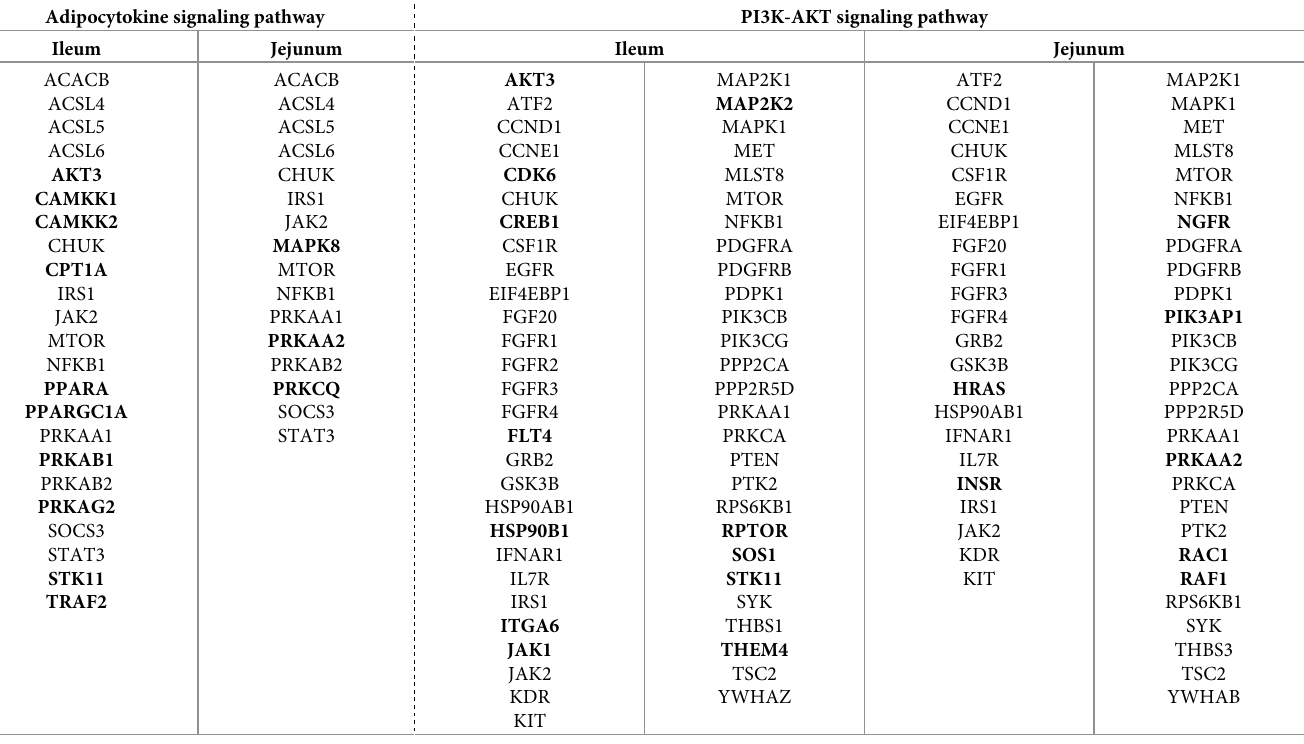
Table 6. Individual proteins in the Adipocytokine and PI3K-AKT signaling pathways that are significantly different in tissues from supplement-fed chickens com- pared to controls. Adipocytokine signaling